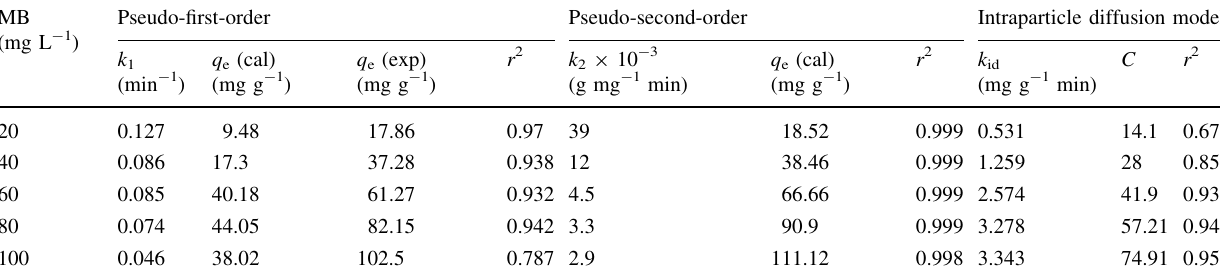
Table 1 Kinetic parameters of pseudo-first-order, pseudo-second-order, and intraparticle models for MB removal using C-ZMN Pseudo-first-order MB (mg L - 1 )